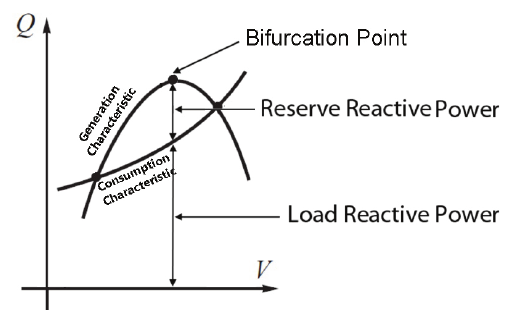
Figure 2. Conceptual visualization of relationship between available reactive power and voltage security—adapted from